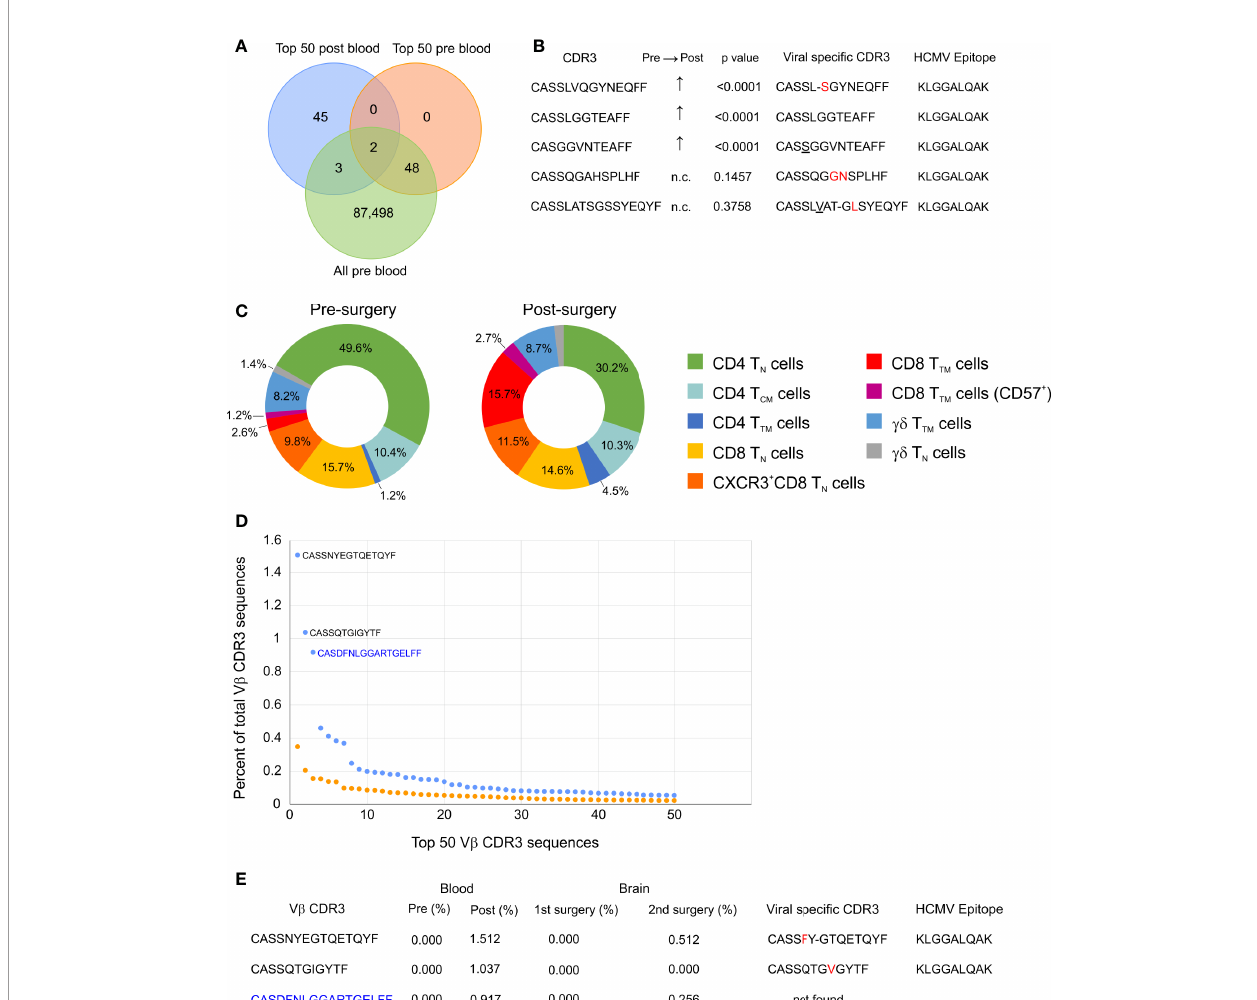
FIGURE 4 | Longitudinal pro fi ling of T cells in a TSC patient. (A) Venn diagram showing the overlap between the top 50 clonotypes present in the blood 5 months after surgery (post blood) and clonotypes present in the blood just prior to the surgery (pre blood). (B) V b CDR3 sequences of the fi ve overlapping T cell clonotypes; the frequency of the three that were not among the top 50 clonotypes in the pre blood are signi fi cantly higher in the post blood. Comparison of the fi ve V b CDR3 sequences to CDR3 sequences that recognize the same HCMV epitope restricted on HLA A*03. Amino acids in red are substitutions and underlined residues are additions; a dashed line indicates a deletion. (C) Donut plots showing the relative frequency of T cell subtypes in CD45 + CD3 + cells from pre- and post-surgery blood. T N , naïve T cells; T TM, transitional memory T cells; T CM , central memory T cells. (D) Comparison of the frequencies of the top 50 clonotypes in pre- and post- surgery blood showing that there are three dominant clonotypes in the post blood re fl ecting an increase in the clonality score from 0.018 ( Table 1 ) to 0.075. The two public V b CDR3 sequences are in black and the private V b CDR3 sequence is in blue. (E) The three dominant clonotypes in the post-surgery blood were not found in the blood or brain from the fi rst surgery, but were found in the single cell TCR sequences from the second surgery. The two public V b CDR3 sequences are similar to virus speci fi c V b CDR3 sequences restricted on HLA-A*03. Amino acids in red are substitutions and a dashed line indicates a